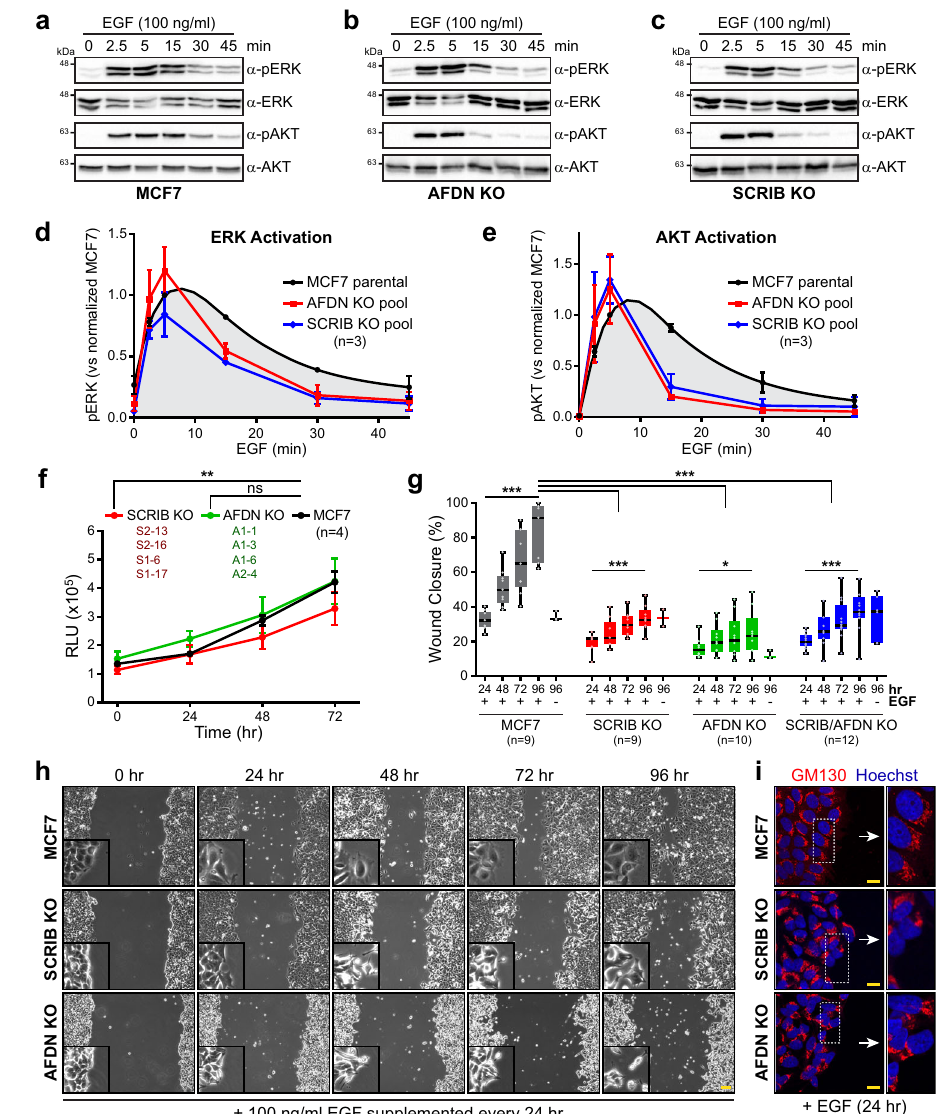
Fig.8|Lossof AFDN or SCRIB disruptsERKandAKTactivationkineticsandcell motilityinagrowthfactor-dependentmanner. ActivationoftheMAPKandPI3K pathwaysfollowingEGFstimulationofMCF7parental( a ), AFDN KO( b )or SCRIB KO ( c ) cells. pERK or pAKT Western blots measure pathway activity 2.5, 5, 15, 30 or 45minutes after addition of EGF. Total ERK and AKT Western blots con fi rmed expression and serve as loading controls. Quanti fi cation of MAPK ( d ; ERK activa- tion) and PI3K ( e ; AKT activation) activity following addition of EGF over time. Center is the mean and errorbars SDas derived from n =3independent replicates. f Effectof AFDN or SCRIB KOon cellproliferation compared to parentalMCF7cells over a 72-hour time course from n =4 independent replicates. Center represents mean and error bars SD. ** P <0.005 ( P =0.003), ns=not signi fi cant ( P =0.298) as measured by two-way ANOVA. g KO of SCRIB or AFDN results in motility defects in response to EGF. Wound closure (%) was measured at 24, 48, 72 or 96hours for MCF7 ( P =0.0001withingroup), AFDN KO( P =0.0145), SCRIB KO( P =0.0001),and